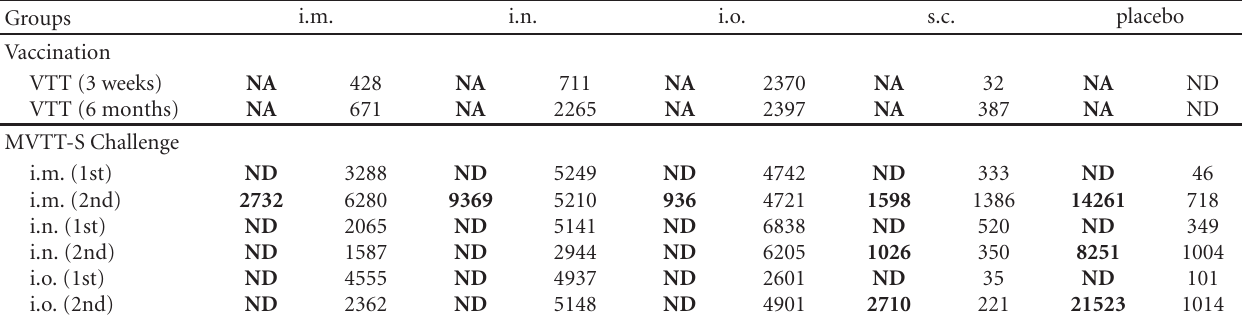
Table 1: Neutralizing antibody titer from di ff erent time points after VTT vaccination and MVTT-S Challenges.